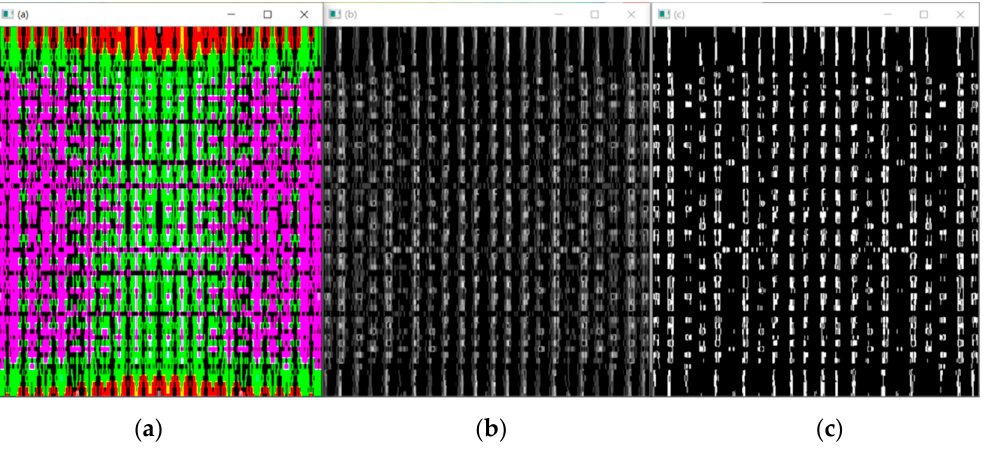
Figure 6. Extraction of the edge information of the ROI. ( a ) Edge detection result; ( b ) grayscale image; ( c ) binarized image.